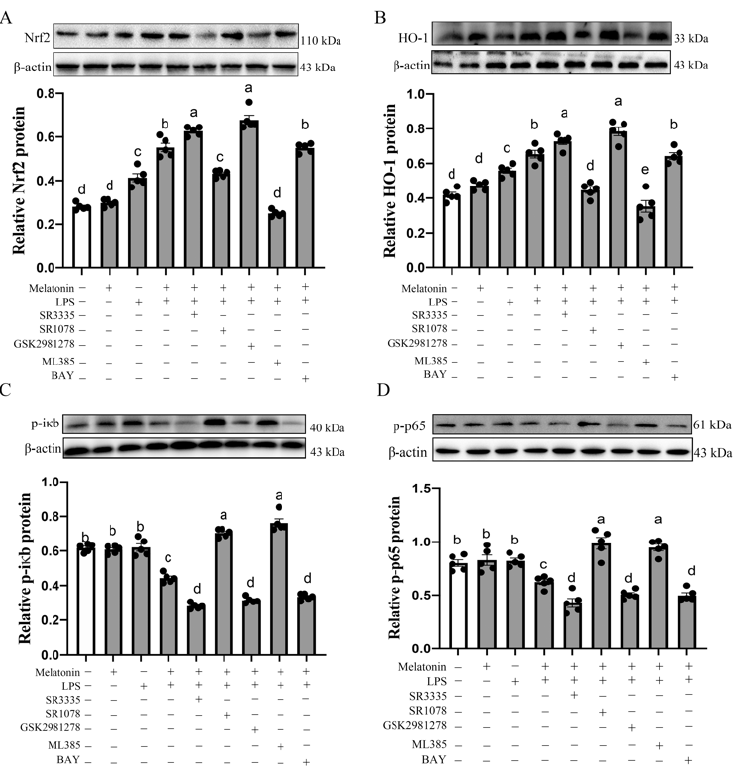
Figure 6. Effects of ROR α antagonists, ROR α agonist, ROR γ antagonist, Nrf2 antagonists and p65 antagonists on Nrf2 ( A ), HO ‐ 1 ( B ), p ‐ i κ b ( C ), p ‐ p65 ( D ) protein level of bursal B ‐ lymphocyte in response to LPS in the G → B group. SR3335 is a ROR α antagonist; SR1078 is a ROR α agonist; GSK1981278 is a ROR γ antagonist; ML385 is an NRF2 antagonist; BAY is a p65 antagonist. Differ ‐ ences between seven light treatment groups were evaluated by one ‐ way ANOVA, and values with no common letters differ significantly ( p < 0.05). As shown in Figure 7A,B, the pretreatment of B lymphocyte with melatonin nuclear receptor ROR α antagonist SR3335 or ROR γ antagonist GSK2981278 significantly reduced